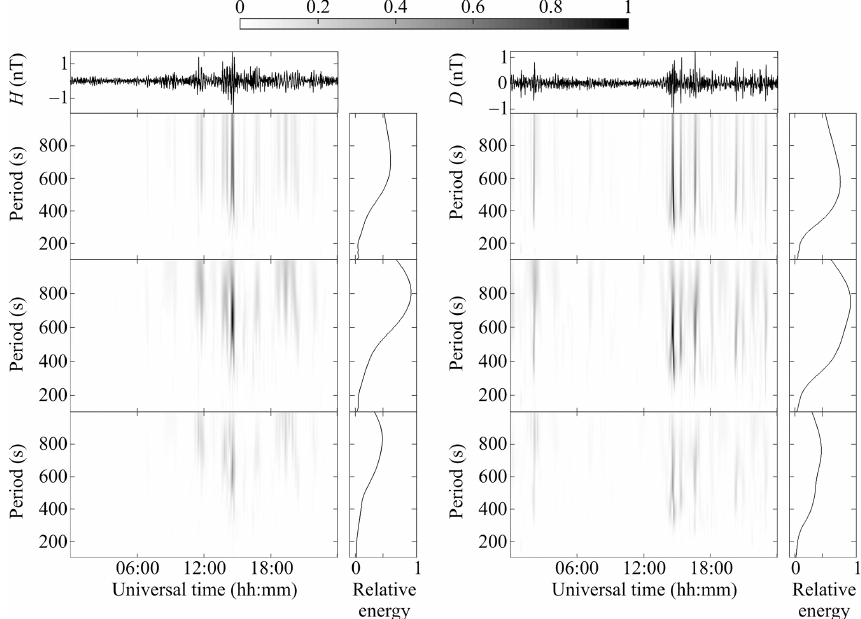
Figure 16. Systems spectral analysis products for the geomagnetic variations on 29 August 2019 at the V. N. Karazin Kharkiv National University Magnetometer